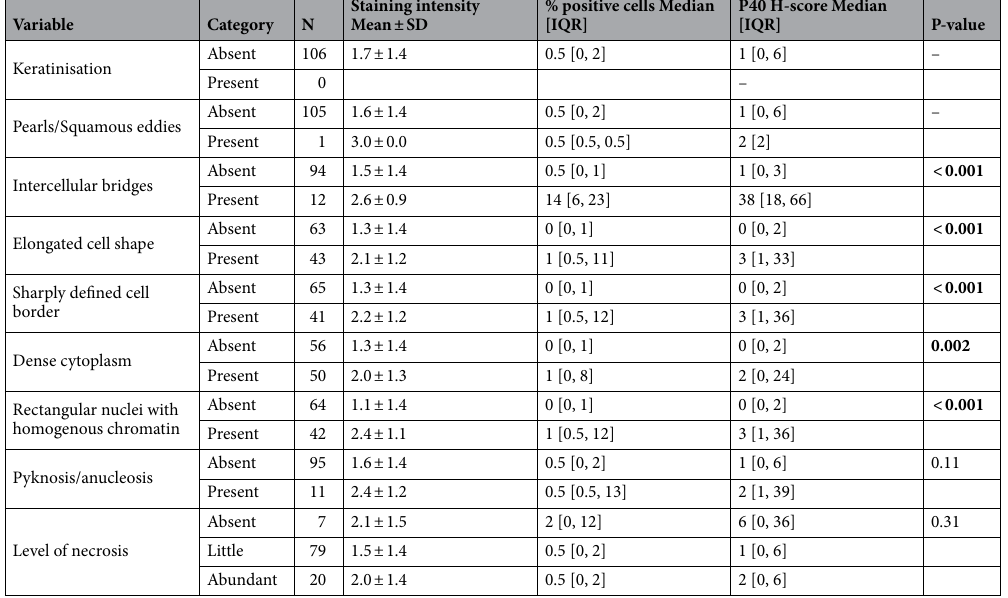
Table 1. Associations between morphological features and FNB p40 H-score. Bold indicates correspond to statistically significant P values of less than 0.05